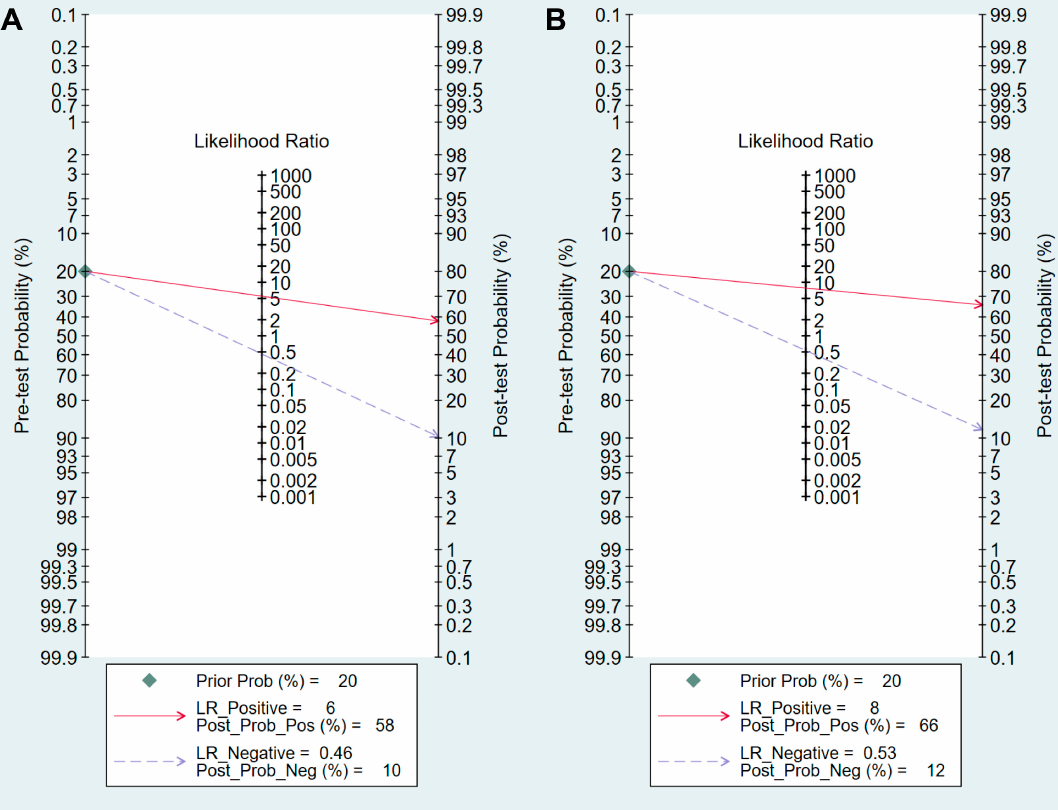
Figure 6. Fagan’s normogram for the diagnosis of CAG. ( A ) cut-off value with PG I ≤ 70 ng/mL and PG I/PG II ratio ≤ 3, ( B ) cut-off value with PG I/PG II ratio ≤ 3. CAG, chronic atrophic gastritis; PG, pepsinogen; LR, likelihood raio.